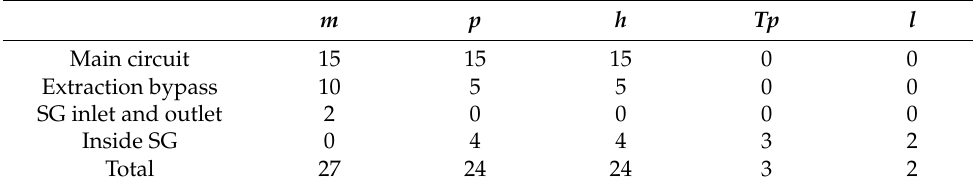
Table 1. Summarization of